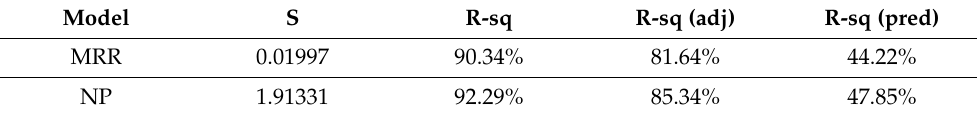
Table 7. Model summary.